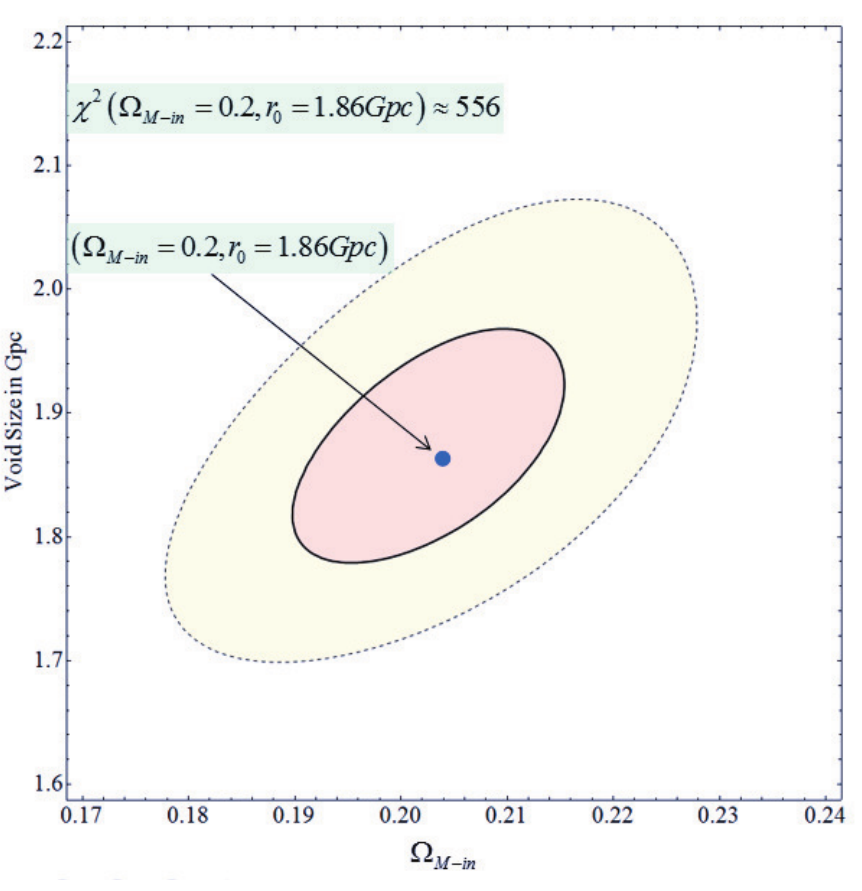
Figure 4. The 1 σ and 2 σ contours for the parameters Ω void) and r (size of the void) (from 0